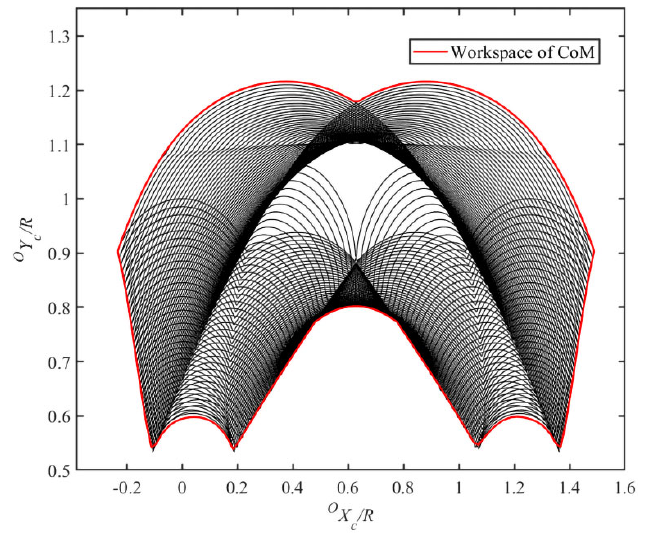
Figure 5. the workspace of the CoM when the rolling angle 𝜙 is in the range of 0 to 2 𝜋 /5 . Figure 5. The workspace of the CoM when the rolling angle φ is in the range of 0 to 2 π /5.